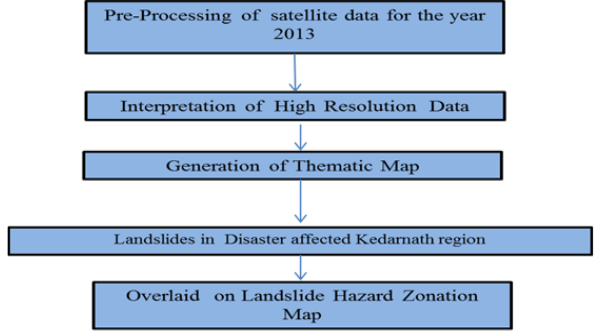
Figure 3. Methodology for Validation of Landslide